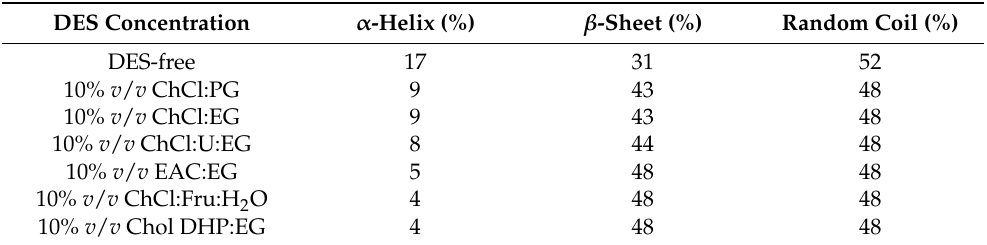
Table 5. CD spectral secondary structural content of free tyrosinase after 24 h of incubation in various DESs (10% v / v ). DES Concentration α -Helix (%) β -Sheet